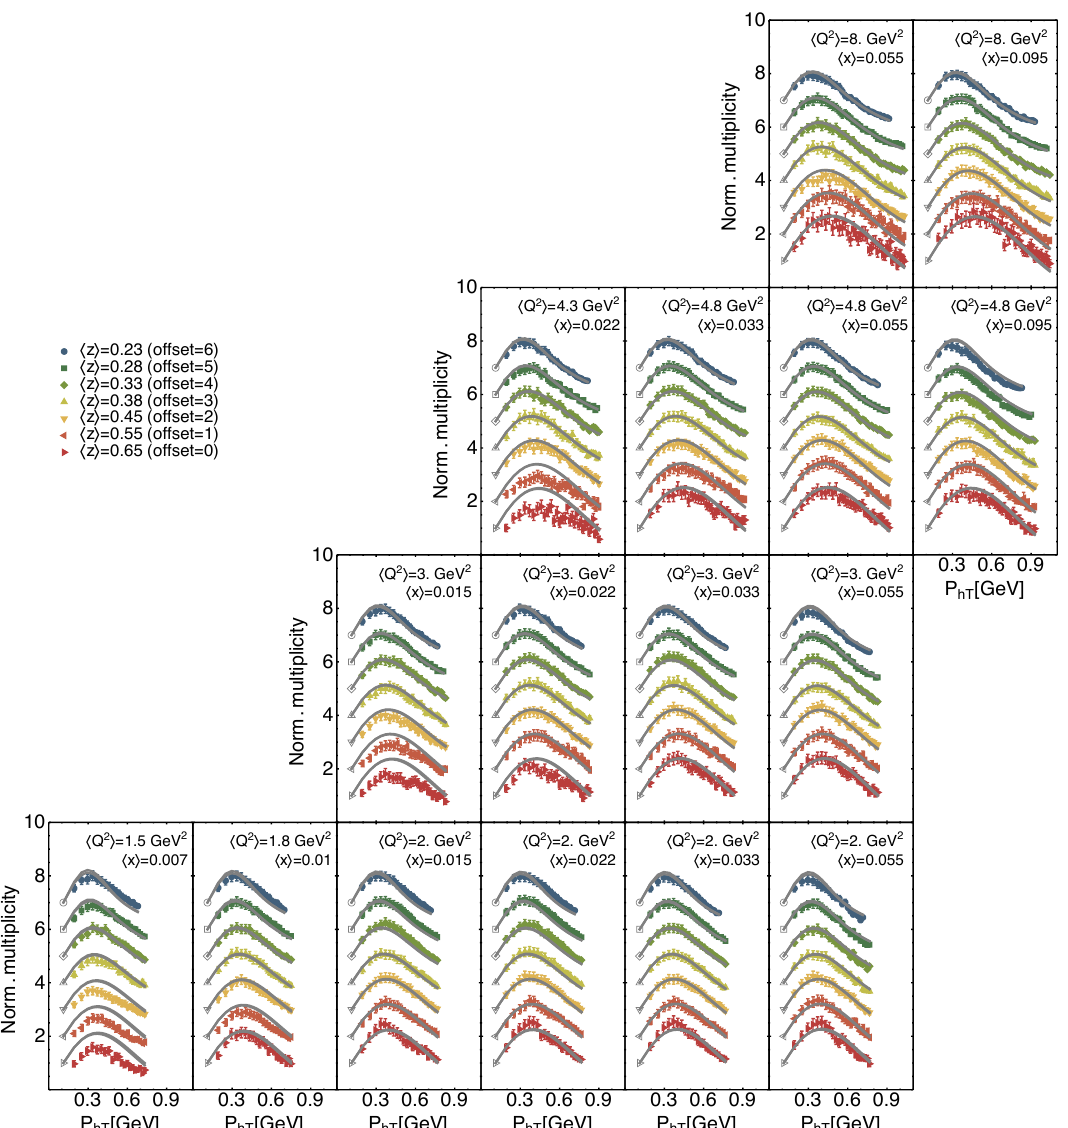
Figure 5 . Compass multiplicities for production of negative hadrons ( (cid:25) (cid:0) ) off a deuteron for different x , z , and Q 2 bins as a function of the transverse momentum of the detected hadron h i h i h i P hT . Multiplicities are normalized to the first bin in P hT for each each z bin has been shifted by an offset indicated in the h i